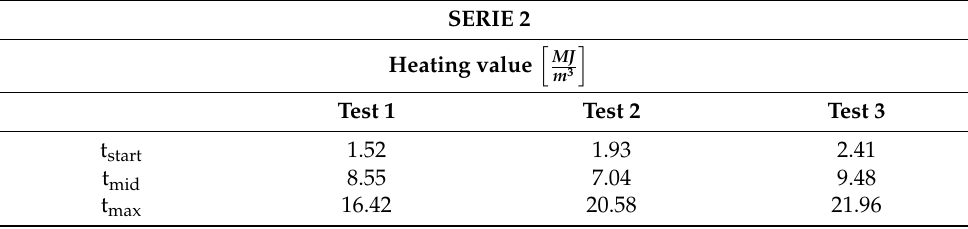
Table 2. Heating value of process gases at the start of the process, during and after achieving the maximum temperature, Serie 2 [21].